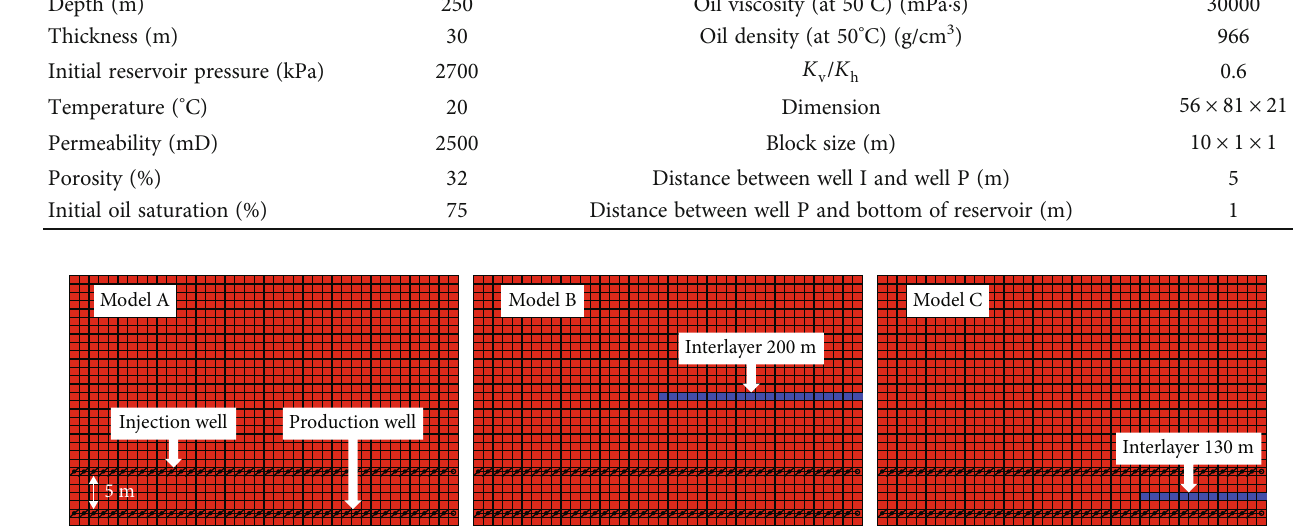
Figure 2: The schematic of well con fi guration and distribution of interlayer in model A, model B, and model C.